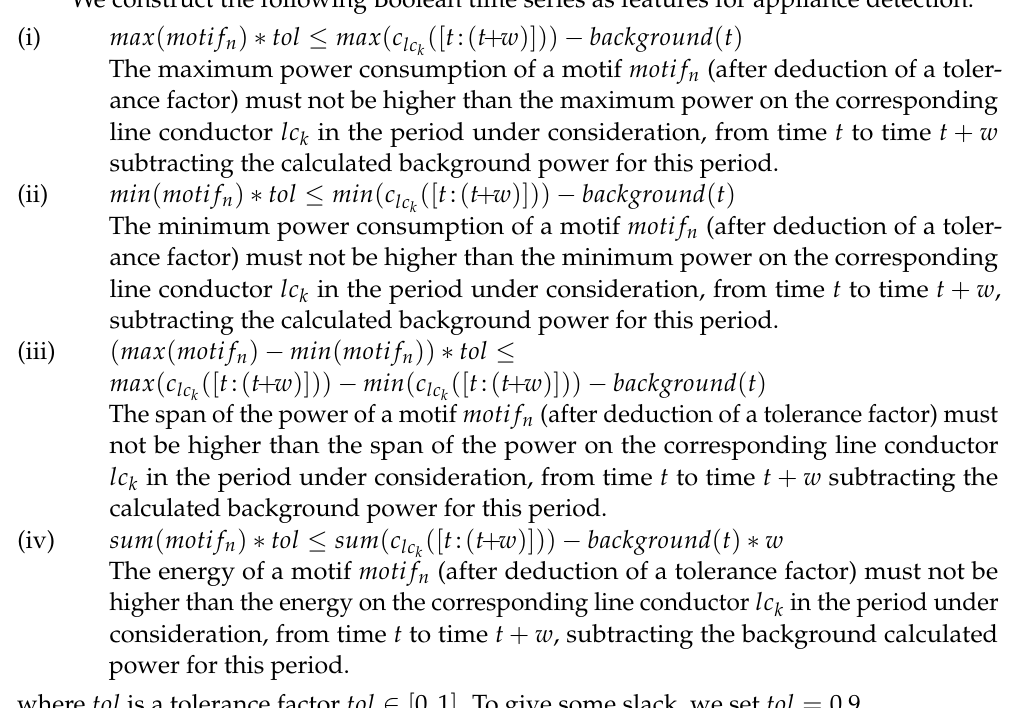
Figure 2. Example for a similarity time series SIM motif rithm with an example motif motif n ∈ M on the corresponding line conductor lc k in a time period where the motif n was active